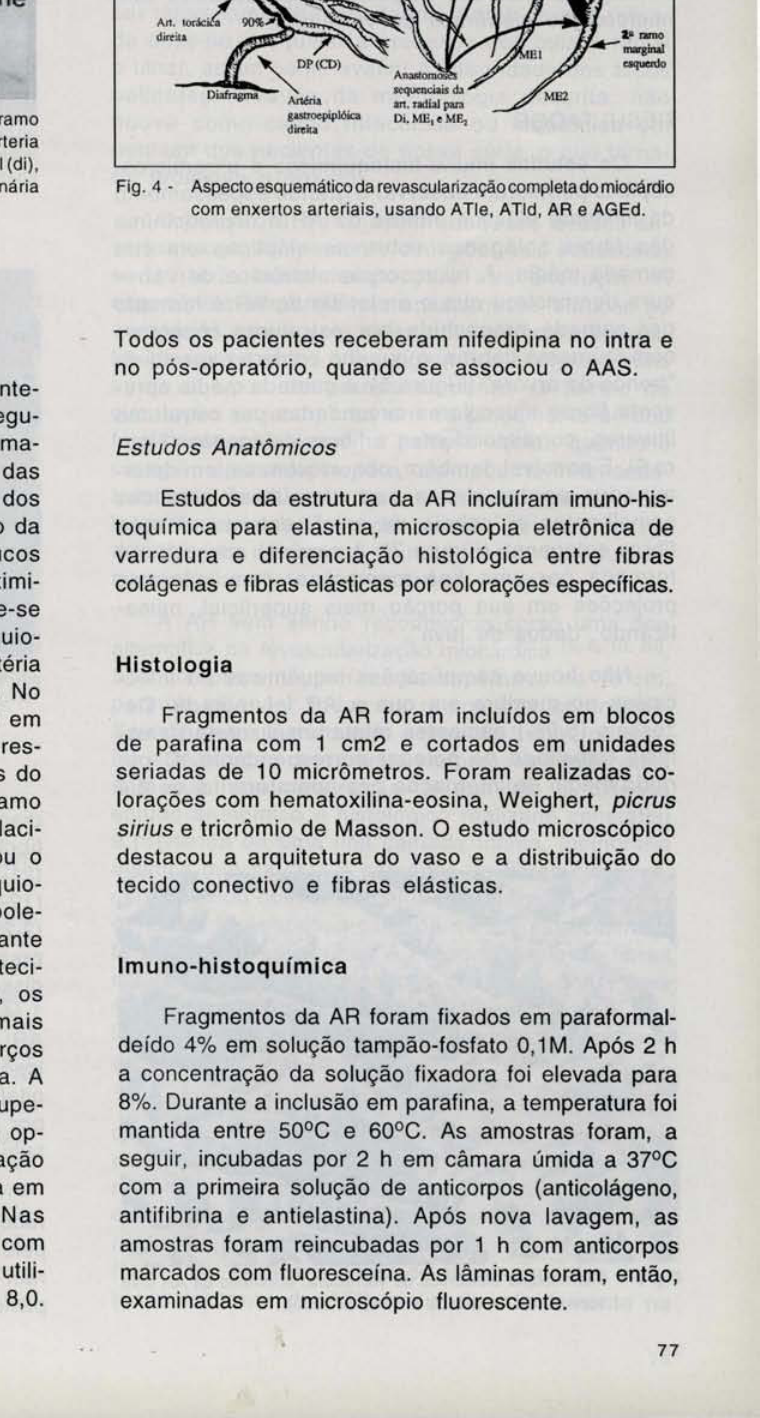
Fig. 3· Anastomose da artéria torácica interna E (ATle) para o ramo interventricular anterior (RIA) (- ). Anastomose da arte ria radial (AR) na ATle e sequencial para os ramos diagonal (di), marginal E (me) e ventricular posterior (VP) da coronária esquerda.